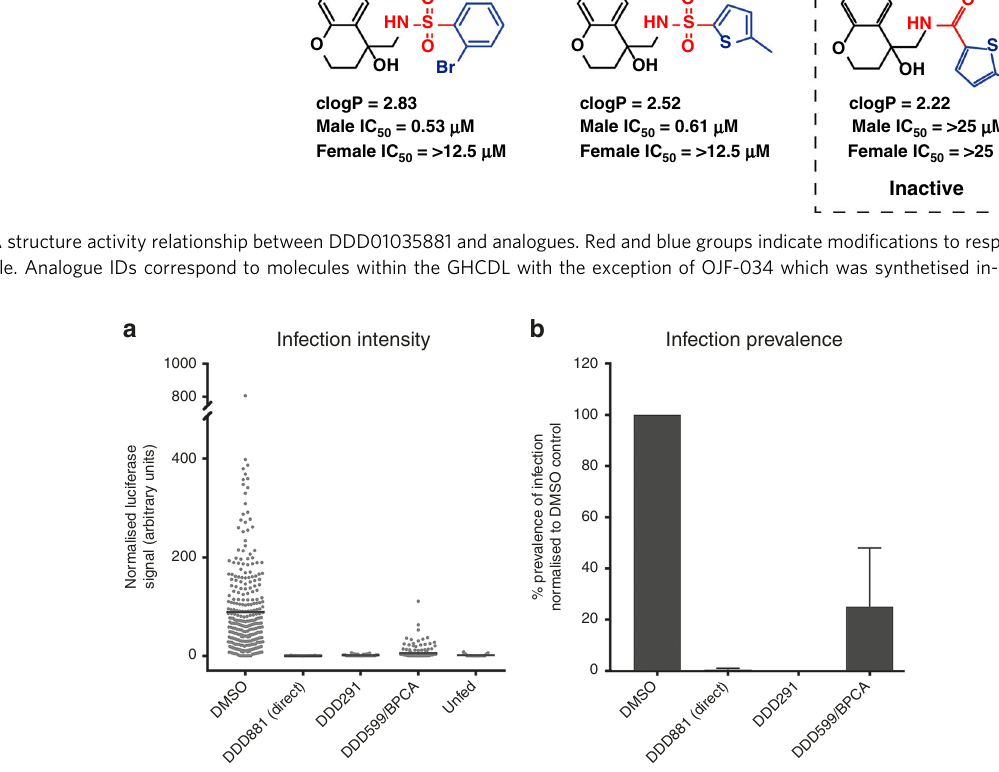
Fig. 8 Transmission-blocking ef fi cacy of leads in P. falciparum SMFA. The predictive power of the Pf DGFA to identify transmission-blocking compounds was assessed by treating GFP/luciferase-expressing P. falciparum gametocytes for 24 h with DMSO, DDD291 or DDD599/BPCA and then feeding them to A. stephensi mosquitoes in indirect mode in which test compound is absent from the blood meal. As DDD881 targets gamete formation rather than gametocytes, membrane feeds with this compound were performed in direct mode, added directly to the blood meal with no prior incubation. a Normalised luciferase intensity from individual mosquitoes ( n = 56 – 72 per condition per replicate) was compared to DMSO and unfed (uninfected) controls. Data combined from three independent biological replicate feeds. Grey dots indicate individual luciferase readout for individual mosquitoes and black bar shows the mean. b Calculated infection prevalence of mosquito feeds normalised to respective DMSO control. Error bars denote the standard error of the